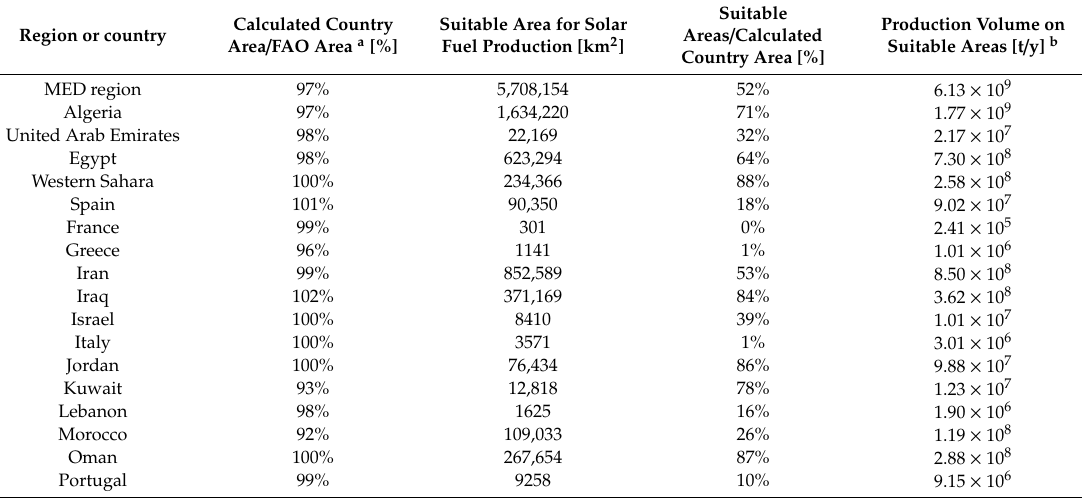
Table A1. Suitable areas and production potential for each